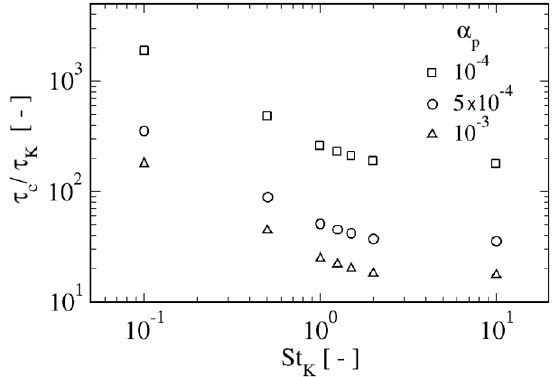
Figure 4. Non-dimensional inter-particle collision time, τ c / τ K , as function of particle Stokes number, St K , for the three evaluated average volume fractions, α p .